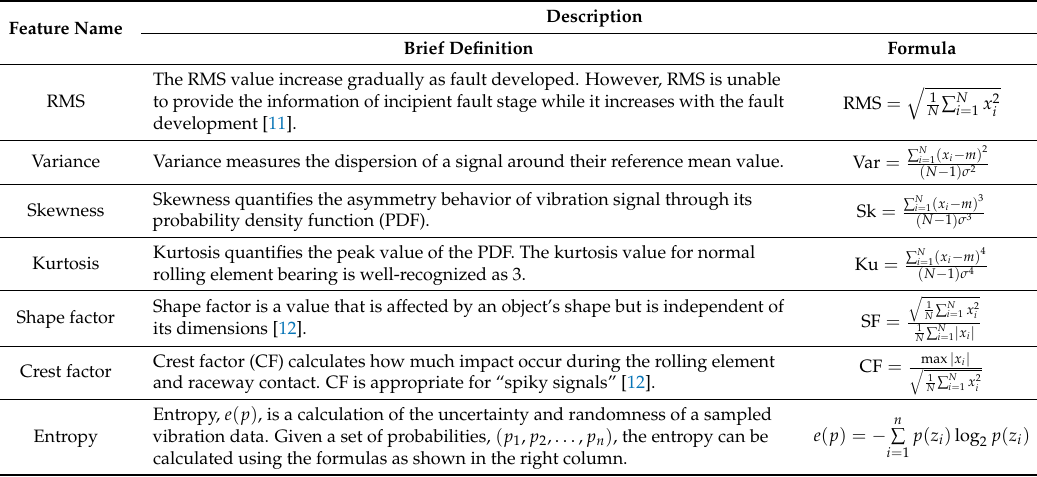
Table 1. Brief review of statistical time-domain features extraction applied in condition monitoring of typical rolling element bearings